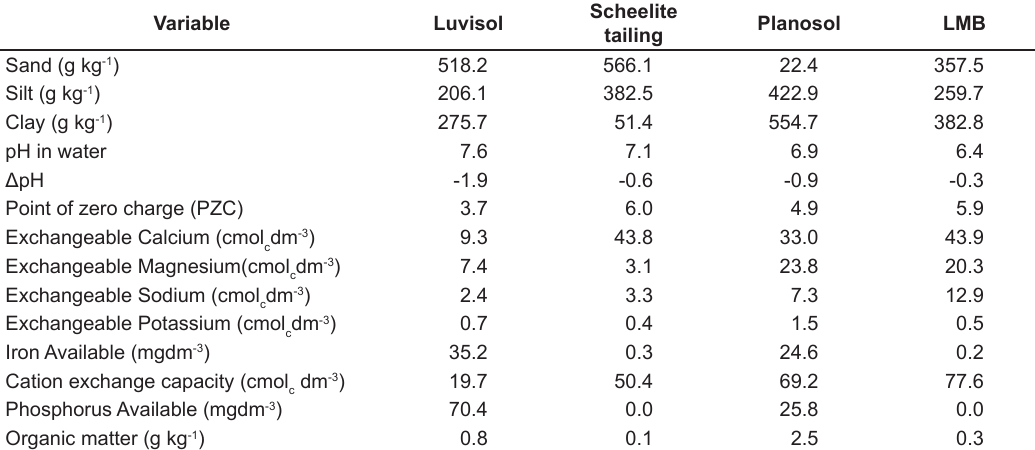
Table 2. Physical and chemical characterization of the P adsorbent materials following the removal of